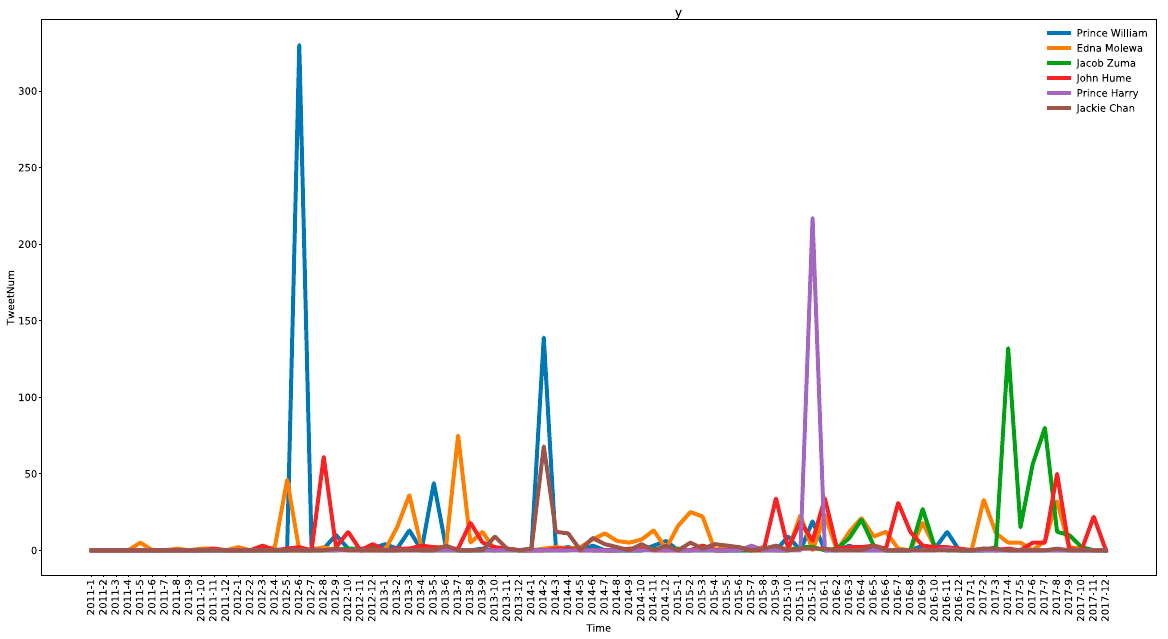
Figure 10. Trends of tweets related to celebrities over time.